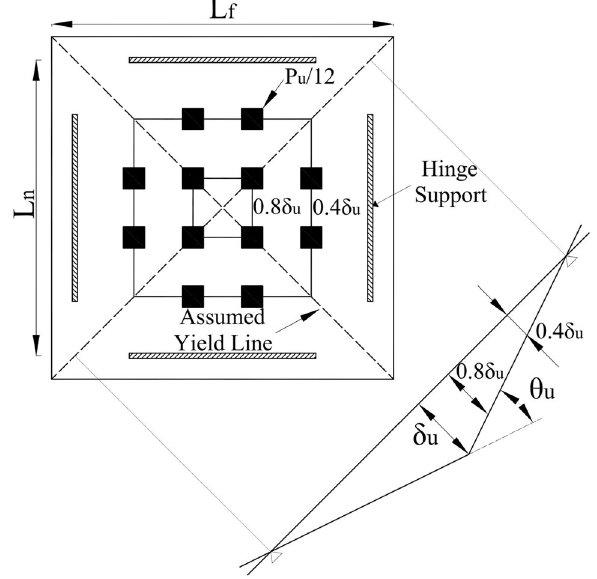
Fig. 7 Assumed yield line and failure